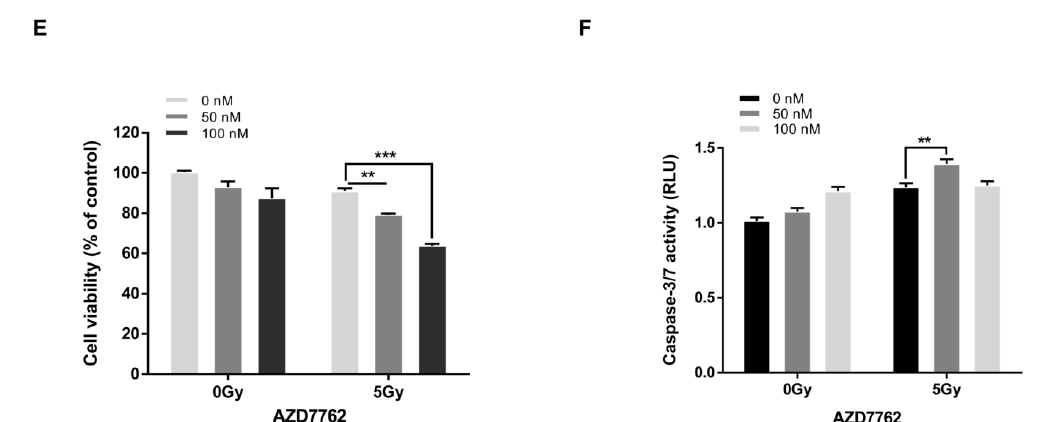
Figure 4. The radioresistant function of CDC20 was mediated by the Mcl-1 / p-Chk1 signal axis. ( A – C ) The expression level of p-Chk1 was detected in Mcl-1 knockdown HCT116 cells ( A ), CDC20 knockdown HCT116 cells ( B ), and Mcl-1-overexpressing HCT116 cells ( C ). ( D ) HCT116 cells were pretreated with di ff erent doses of AZD7762 (0–100 nM) for 24 h before 5 Gy gamma-ray irradiation, and the expression levels of γ H2AX, Rad51, and cleaved caspase-3 were detected 24 h after irradiation. ( E , F ) HCT116 cells were pretreated with di ff erent doses of AZD7762 (0–100 nM) for 24 h before 5 Gy irradiation; cell viability ( E ) and caspase-3 / 7 activity ( F ) were detected 24 h after 5 Gy γ -radiation. Actin was used as an internal control. Data were pooled from three independent experiments and the results are represented as mean ± SD; * p < 0.05, ** p < 0.01, *** p < 0.001.